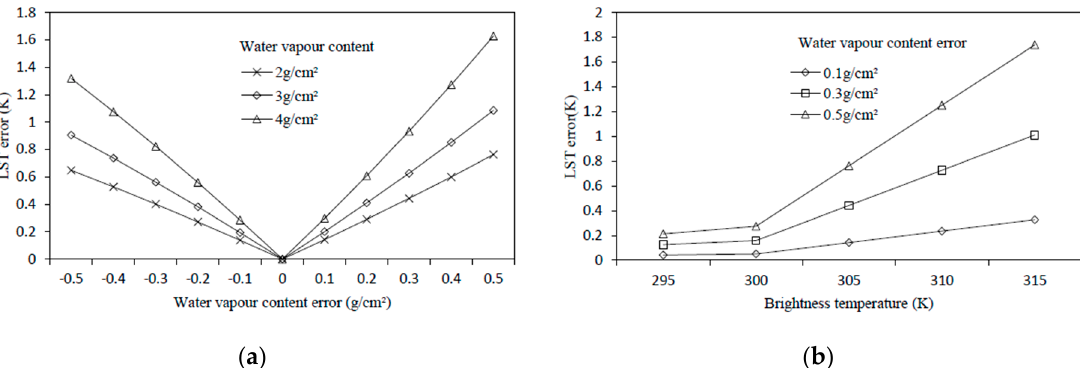
Figure 6. LST estimation error of the mono-window algorithm as a result of the estimation error in the water vapor content. ( a ) LST error against water vapor content error, and ( b ) LST error against brightness temperature for different water vapor content errors; water vapor content was kept constant at 2 g/cm².